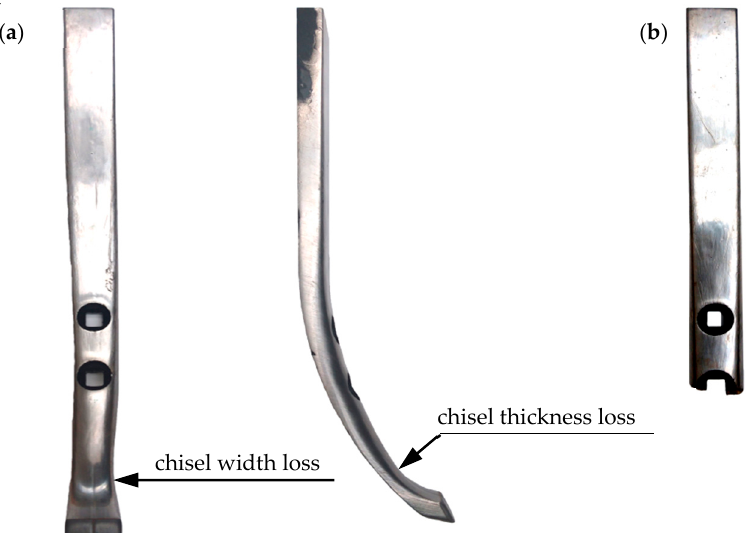
Figure 5. The geometry of the selected chisel B after disassembly: ( a ) element without the wear limit state and ( b ) broken element.